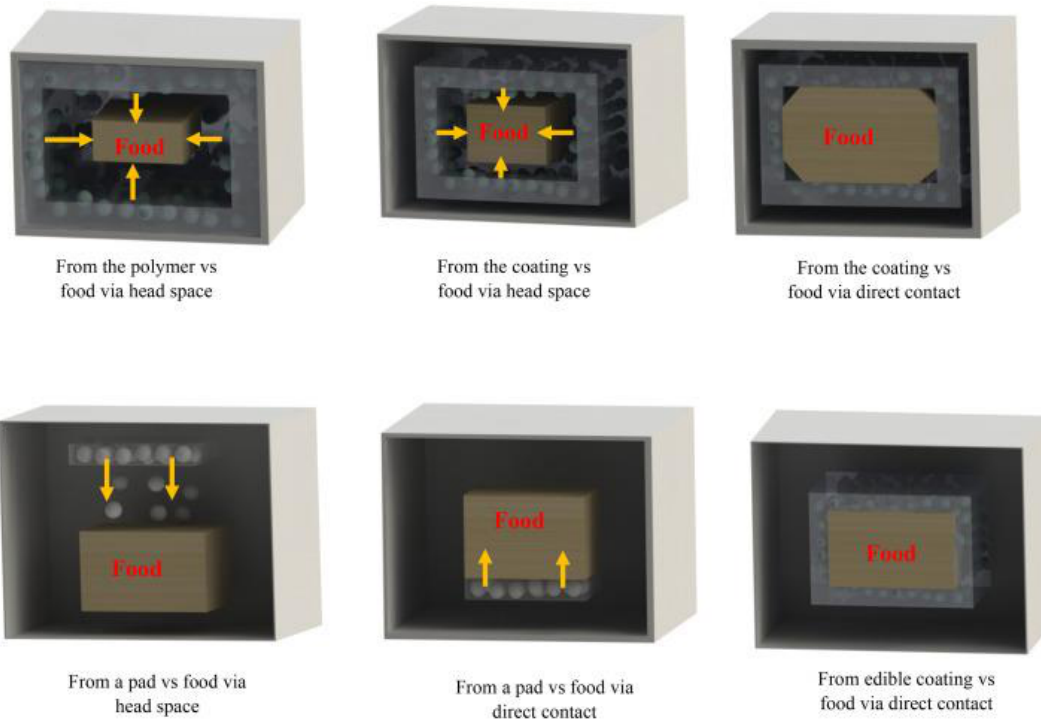
Figure 12. Possible methods for the release of antimicrobial agents in active packaging. Reproduced with permission from [1]. (Copyright 2020 Elsevier).